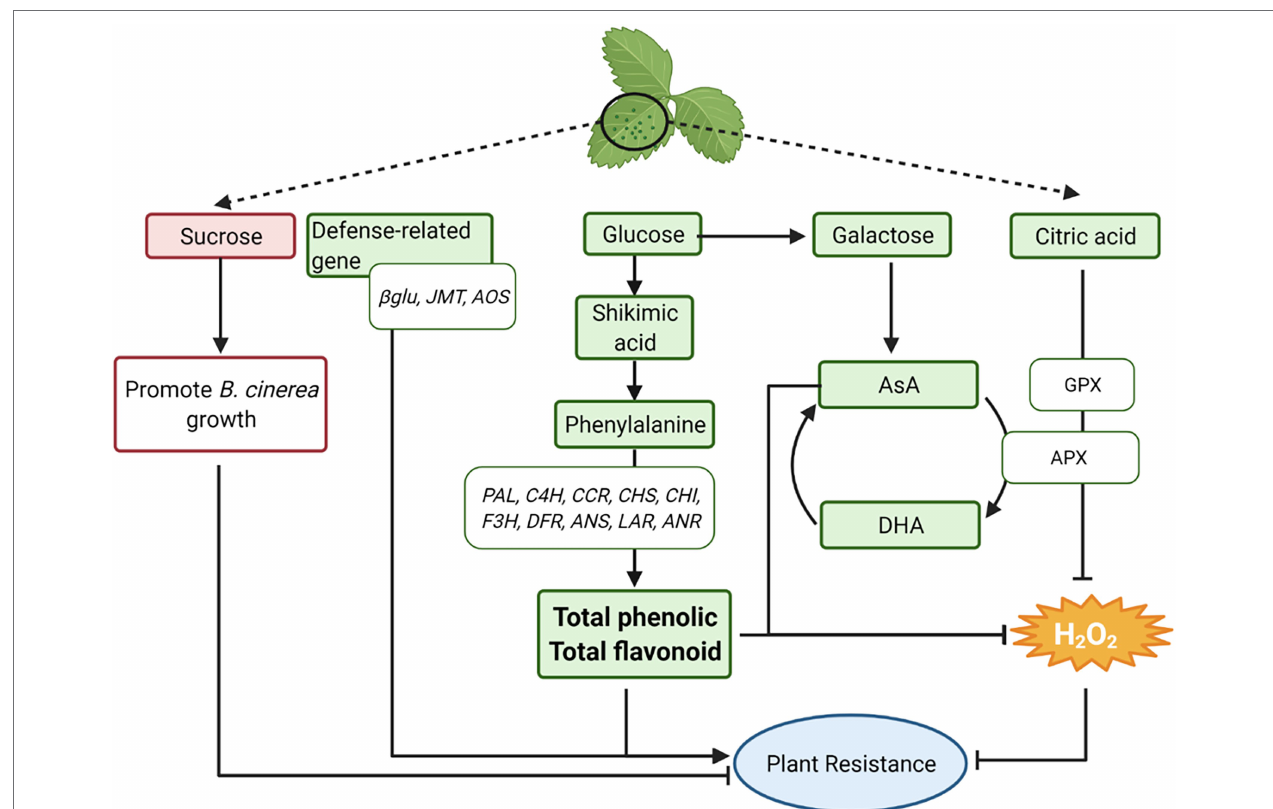
FIGURE 12 | A conceptual model illustrating potential resistance mechanisms to B. cinerea in the more tolerant woodland strawberry F. vesca ssp. vesca Kreuzkogel 1 (K1) including primary metabolites, H 2 O 2 , phenolic compounds, ascorbic acid and defense-related genes. A detailed description of the figures can be found in the “Summary of Potential Mechanisms for Higher Resistance of K1 to B. cinerea Than T3”. The green boxes represent a higher content of the specific metabolites/genes in genotype K1 compared to T3, while the red boxes represent a lower content. β GLU: β -1,3-GLUCANASE, JMT: JASMONIC ACID CARBOXYL METHYLTRANSFERASE, AOS: ALLENE OXIDE SYNTHASE; PAL, PHENYLALANINE AMMONIA LYASE; C4H, CINNAMIC ACID 4-HYDROXYLASE; 4CL, 4-COUMAROYL-COA LIGASE; CCR: CINNAMOYL-COA REDUCTASE; CHS, CHALCONE SYNTHASE; CHI, CHALCONE ISOMERASE; F3H, FLAVANONE 3-HYDROXYLASE; FLS, FLAVONOL SYNTHASE; DFR, DIHYDROFLAVONOL REDUCTASE; ANS, ANTHOCYANIDIN SYNTHASE; LAR, LEUCOANTHOCYANIDIN REDUCTASE; ANR, ANTHOCYANIDIN REDUCTASE; APX: ASCORBATE PEROXIDASE, GPX, GLUTATHIONE PEROXIDASE . This figure has been created with